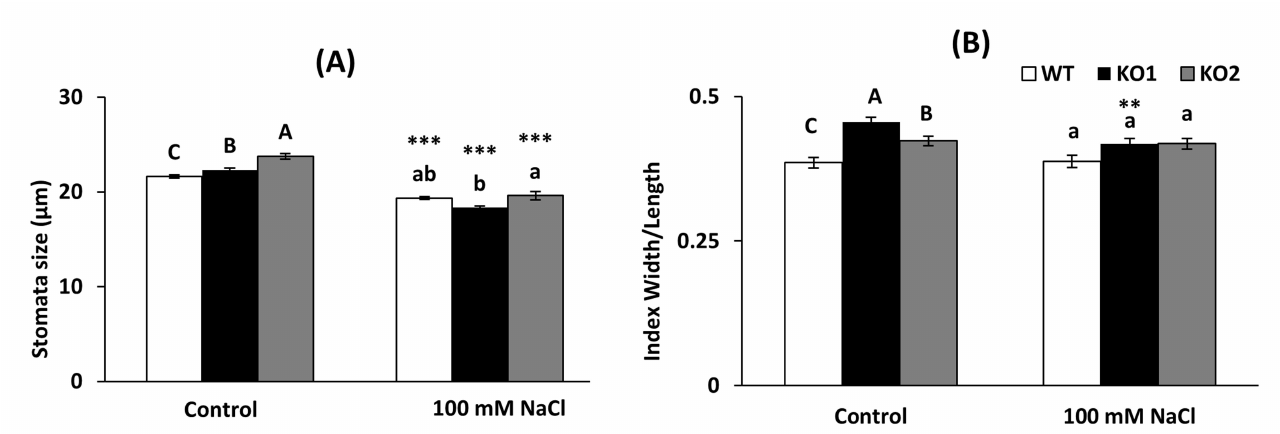
Figure 3. ( A ) Stomatal size and ( B ) opening index measured on the abaxial epidermis of the leaves in A. thaliana wild type (WT) and two KO Attrxo1 mutant lines grown in the absence (Control) and presence of 100 mM of NaCl. The aperture index represents the measurement of the width/length of the stomatal pore. Data are the mean ± SE of three independent experiments ( n > 500 stomata per genotype and treatment). Different letters indicate significant differences ( p < 0.05) among genotypes in each condition according to the Tukey’s test, and the asterisks indicate significant differences of each genotype in salinity compared to the control condition using the t -Student’s test (**, *** at p < 0.01 and p < 0.001, respectively).